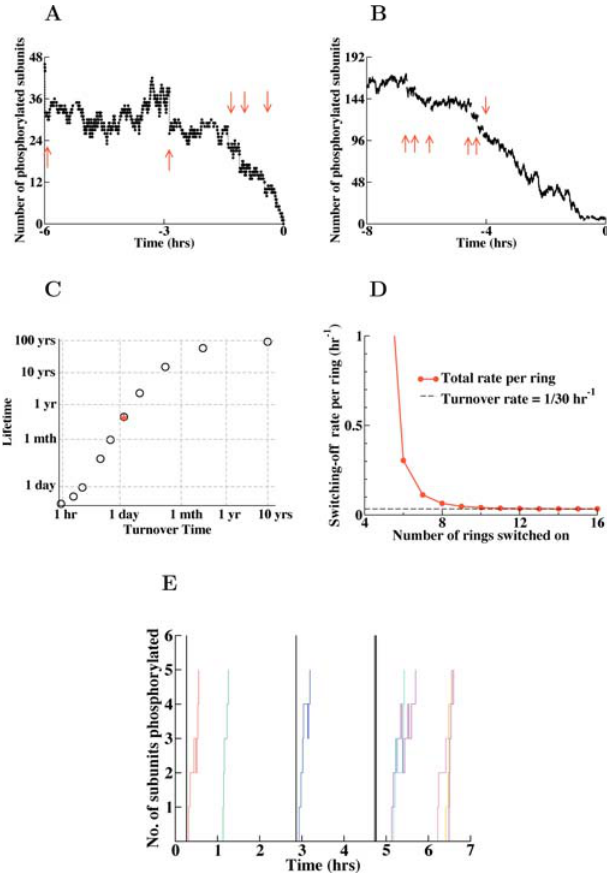
Figure 4. The Rate of Protein Turnover Limits the Maximal Lifetime of the System and Leads to a Minimal Rate of Energy-Consuming Activity (A and B) Stochastic changes in total phosphorylation during a transition from the UP to DOWN state, with turnover events marked by arrows, in a system with (A) four CaMKII holoenzymes and (B) 16 CaMKII holoenzymes. Red arrows indicate turnover events, which cause an abrupt drop in the level of phosphorylation. (C) Log–log plot of lifetime of the switch as a function of turnover rate for the system with eight CaMKII holoenzymes (the red asterisk marks 30-h turnover, used as standard in this paper). (D) The rate for an individual ring of subunits to switch off as a function of the total number of rings that are on (shown here for a system with eight CaMKII holoenzymes). As more rings are turned on, the phosphatase activity saturates and the equilibrium level of phosphorylation per ring increases. As a result, the switching-off rate for rings in the UP state for the system approaches the turnover rate (dashed line), because the probability of total ring dephosphorylation by PP1 becomes small. (E) Dynamic equilibrium between turnover (vertical solid black lines) and switching on of rings (colored step-like lines) when the system is in the UP state. At the time of the first turnover, five rings are already unphosphorylated by prior turnover. The system is stable because the rate of rings switching on matches the rate of turnover of phosphorylated rings (each turnover event can result in the loss of zero, one, or two phosphorylated rings). A system with 20 holoenzymes is